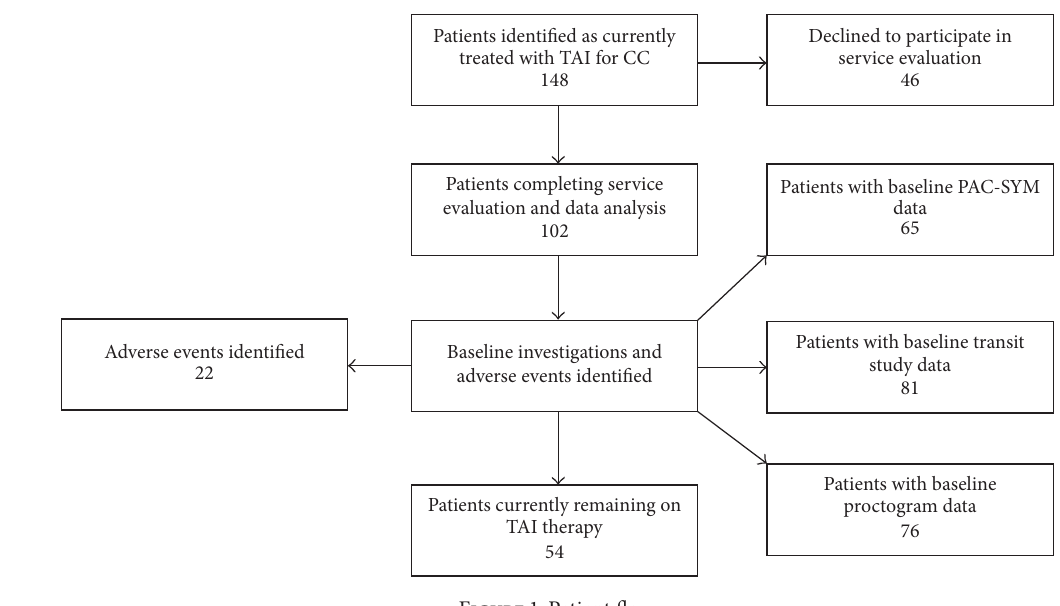
Figure 1: Patient flow.